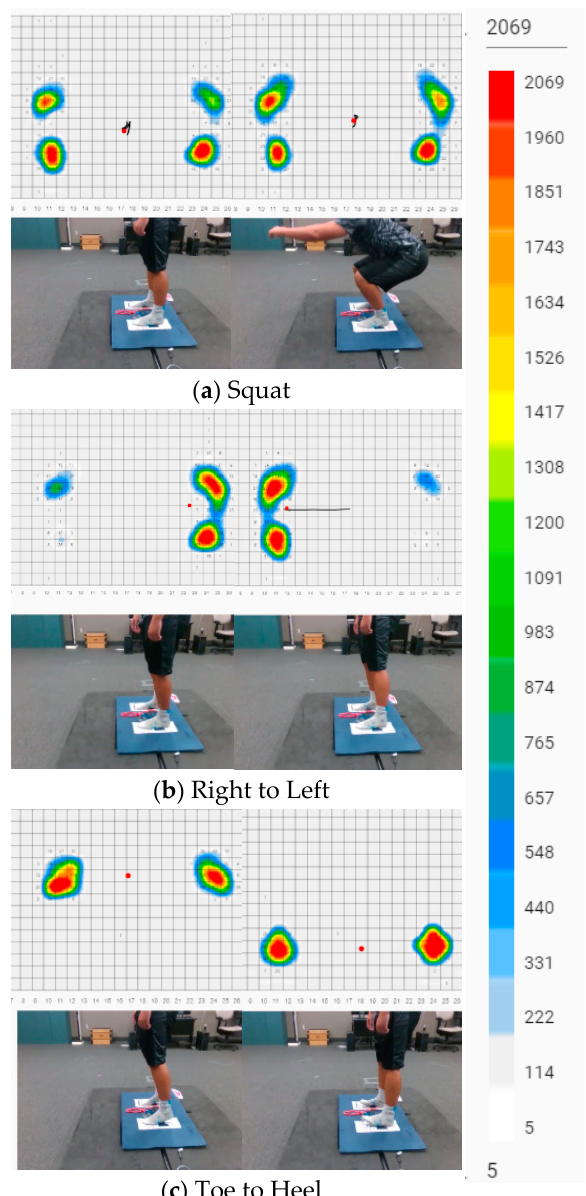
Figure 3. Pictures of the three movements, ( a ) squats, ( b ) shifting right to left, and ( c ) shifting toes to heels. Visual heat map of the individual pressure cells and center-of-pressure output (red dot with trail) from BodiTrak TM Pro 6.0. White cells indicate 5 mmHg (1 kPa) increasing pressures to red indicating 2068.8 mmHg (276 kPa).